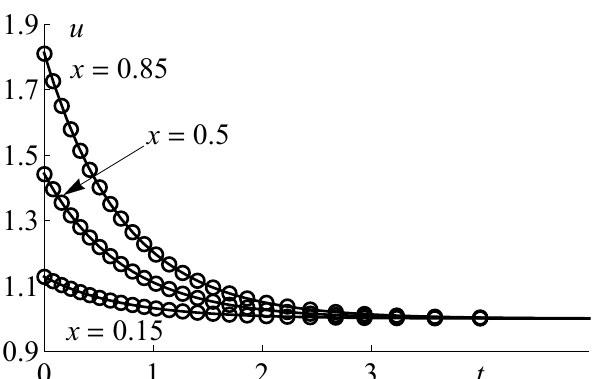
Figure 5. The exact solutions (solid lines) and numerical solutions obtained by the combination of the method of lines and the second-order implicit Runge–Kutta method (circles) of test problem 3 for a = 1, k = τ = 0.5, and N = 100 at different times ¯ t = t / τ .